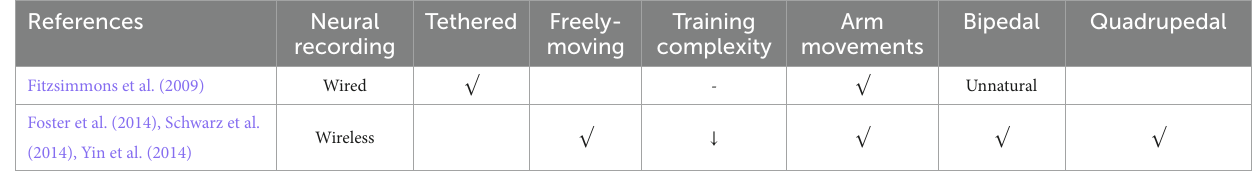
TABLE 6 Comparison of wired and wireless neural recording systems and